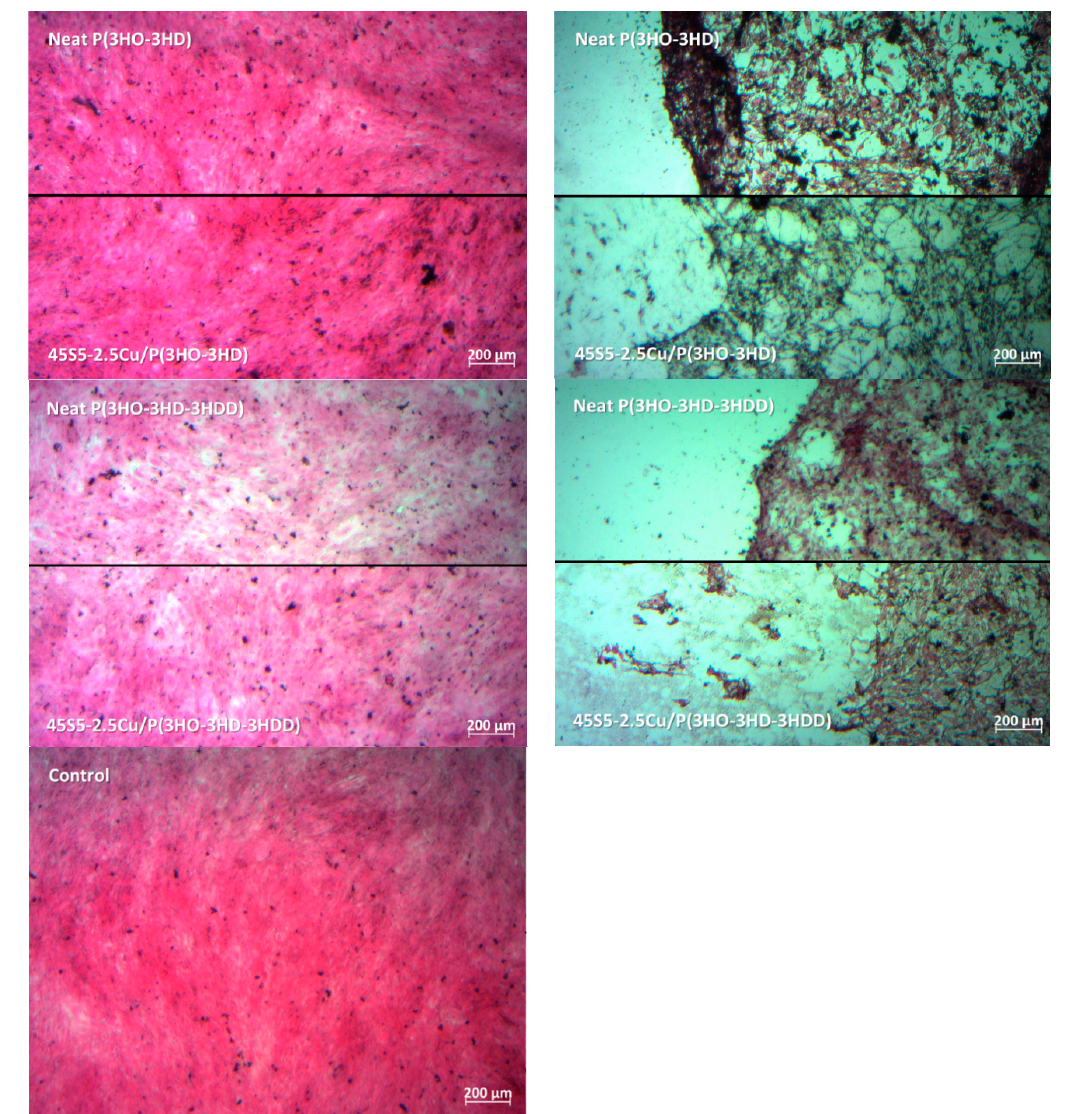
Figure 3. Images of hematoxylin and eosin (H&E)-stained cells cultured in 1% (left) and in 10% (right) dilution of the dissolution products of the different neat and composite PHA scaffolds. Cells cultured in CCM containing no dissolution products were used as control.